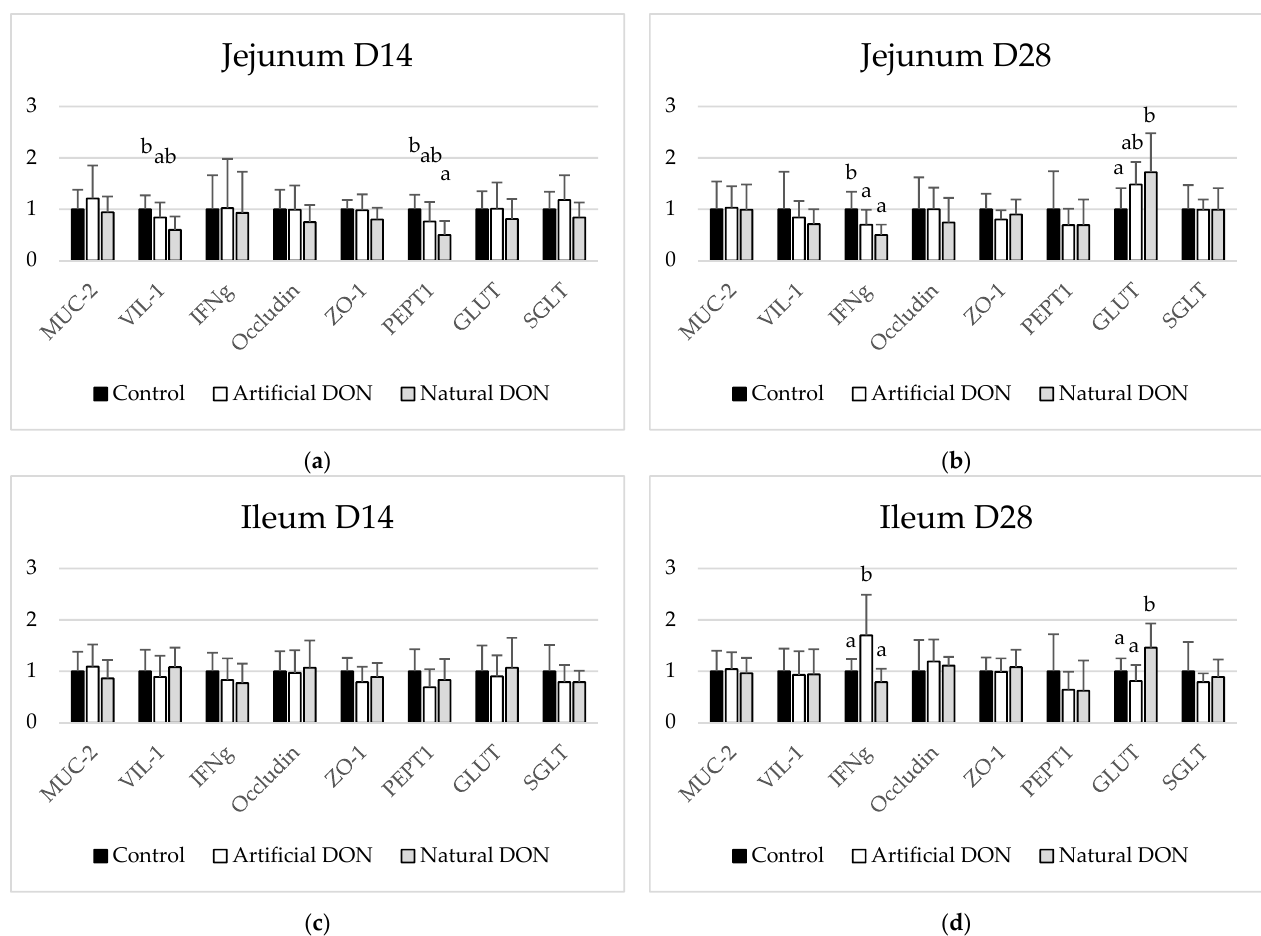
Figure 3. Effect of experimental diets on the mRNA expression of MUC-2, VIL-1, IFNg, occluding, PEPT1, GLUT1, and SGLT in the: ( a ) jejunum of 14-days-old broiler chickens; ( b ) jejunum of 28-days-old broiler chickens; ( c ) ileum of 14-days-old broiler chickens; ( d ) ileum of 28-days-old broiler chickens. a,b Different superscripts indicate significant differences among treatments ( p ≤ 0.05).